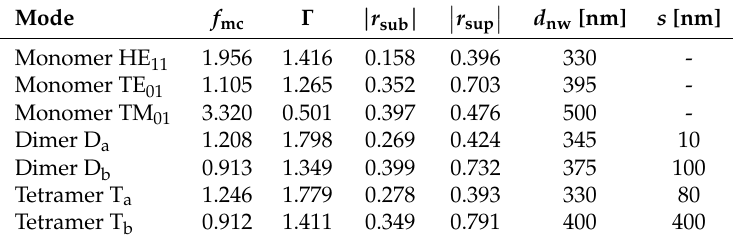
Table 1. Minimum modal cost function ( f mc , Equation (3)) values in the studied parameter space with the selected uncoated nanowire oligomer modes. The corresponding modal confinement factors ( Γ ), substrate, and superstrate modal reflection coefficient magnitudes ( | r sub | and nanowires ( d nw ), and separation of the nanowires ( s ) are also